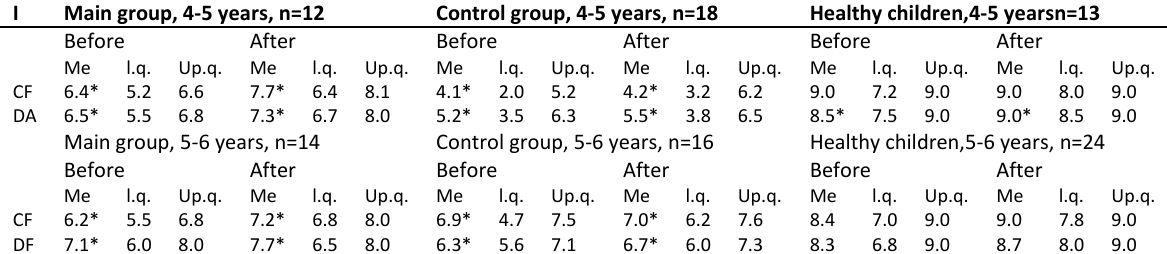
Table 1. Change of cognitive functions and dance abilities in 4-6 years’ age children with speech disorders and in healthy children 1.